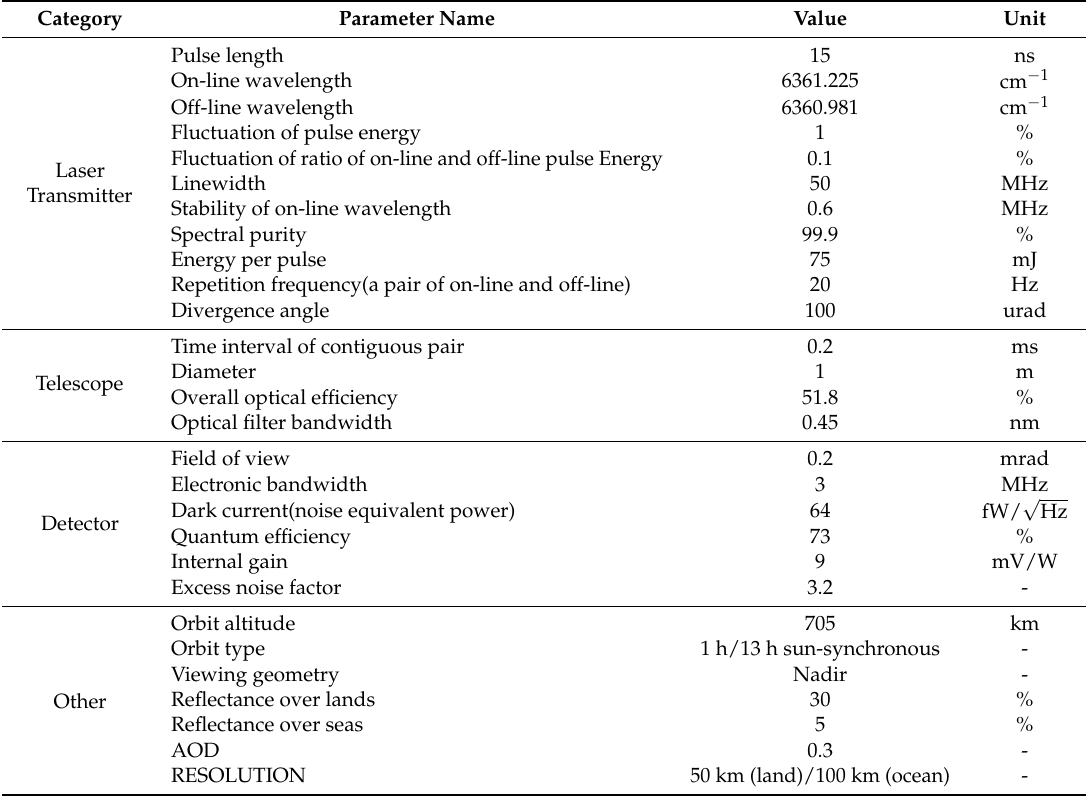
Table 3. Parameter configuration for China’s CO 2